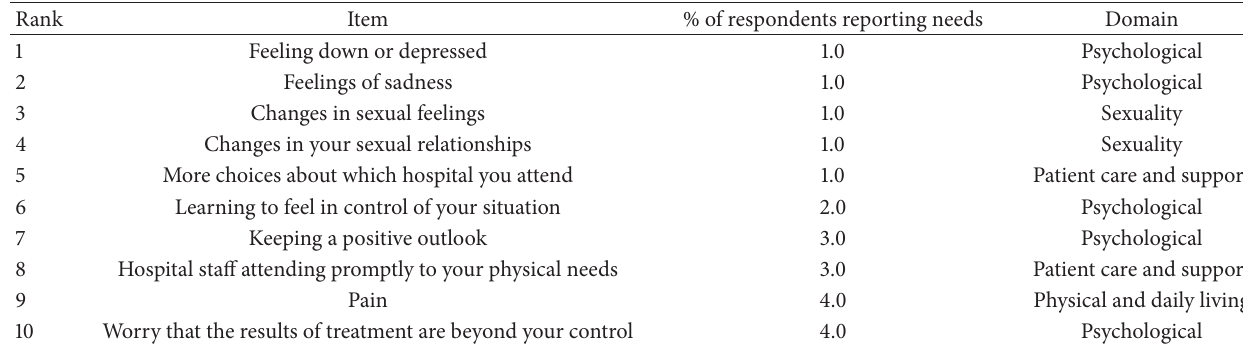
Table 4: Top ten items with lowest “moderate to high” unmet needs ( 𝑁 = 101